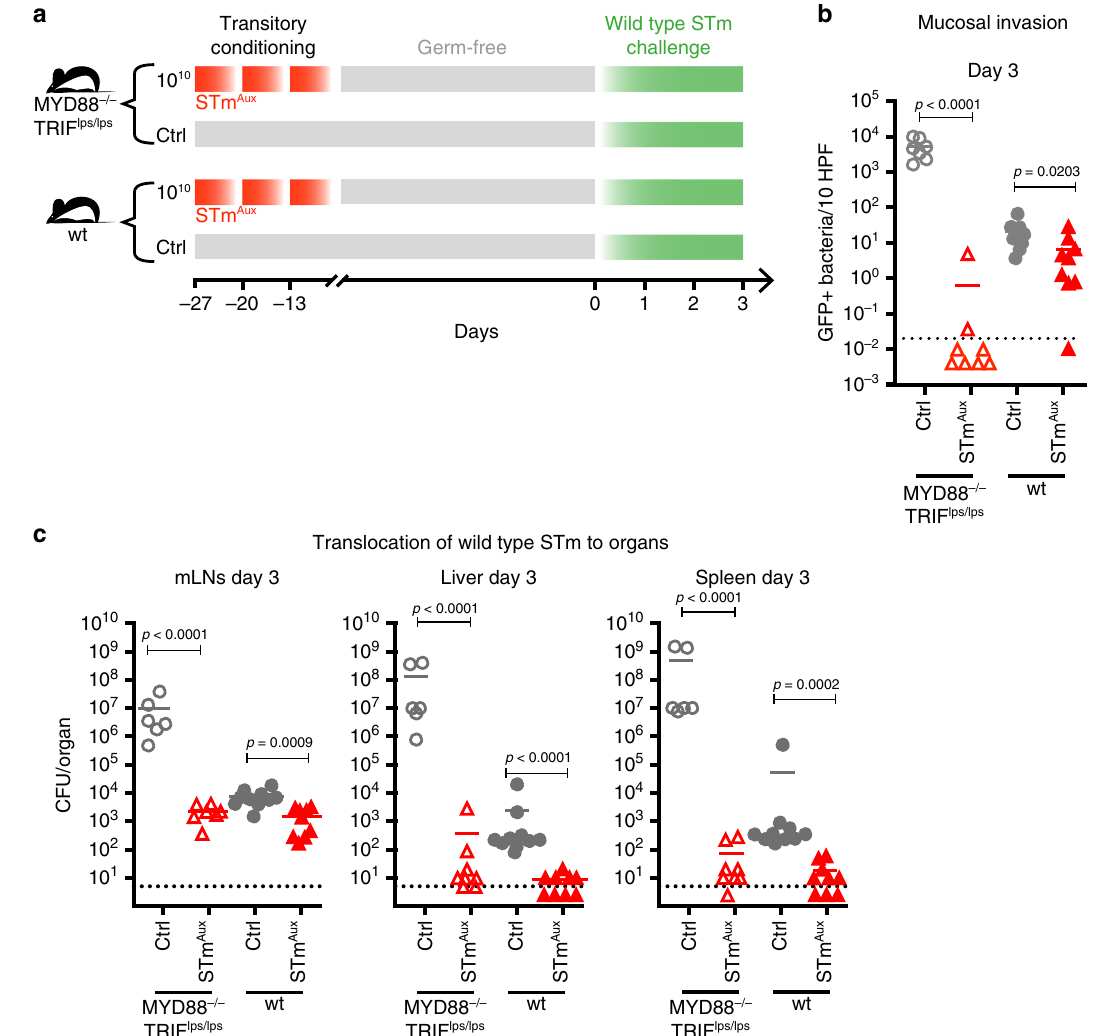
Fig. 5 Mucosal induction of adaptive immunity by live STm Aux is robust in MYD88/TRIF double-de fi cient mice. a Germ-free MYD88 − / − TRIF lps/lps mice (open symbols) and wild-type control mice ( fi lled symbols) were enterally conditioned with three doses of 10 10 CFU of live STm Aux (red triangles, n = 7 MYD88/TRIF KO animals and n = 9 wild-type animals examined over two independent experiments) or left untreated as controls (gray circles, n = 6 MYD88/TRIF KO animals and n = 10 wild-type animals examined over two independent experiments). Twenty-seven days after the fi rst treatment (day 0) mice were challenged with wild-type STm (10 3 CFU) harboring ssag::eGFP reporter plasmid pM973. The mice were studied at day 3 after challenge. Each symbol represents one individual. b Quanti fi cation of intracellular wild-type STm expressing eGFP in the cecal mucosa. c Bacterial burden of wild-type STm recoverable from mLN, spleen, and liver at day 3 after challenge. Statistics: bars indicate mean ( b , c ). Horizontal, dotted lines indicate the lower detection limit ( b , c ). Panels b and c were analyzed with two-way ANOVA (host genotype and treatment as factors) and Sidak multiple comparison correction. The data were pooled from two independent experiments. Source data are provided as a Source Data fi le. Detailed statistical metrics are available in the Supplementary Statistical Analysis fi